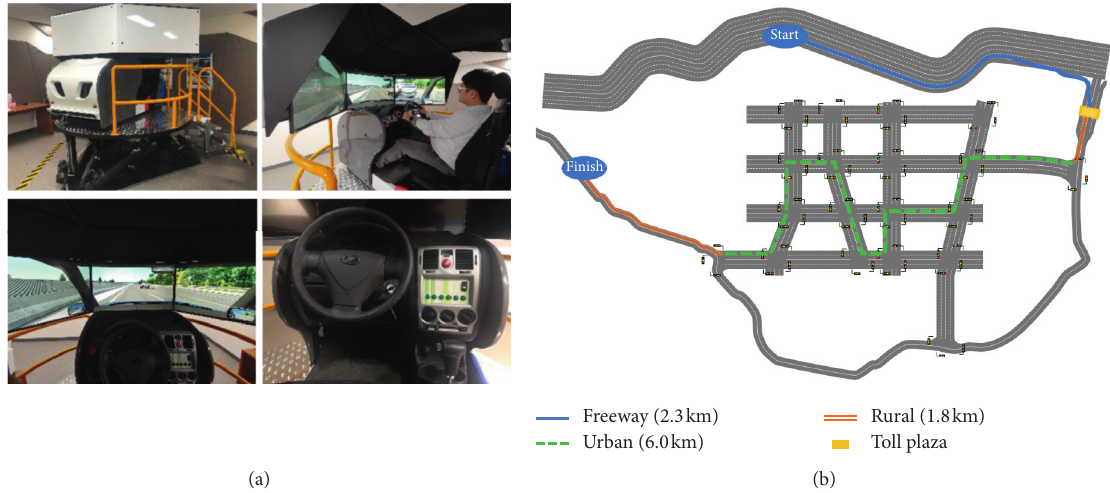
Figure 2: Driving simulator and scenario in this study: (a) the driving simulator set-up; (b) the designed route in the